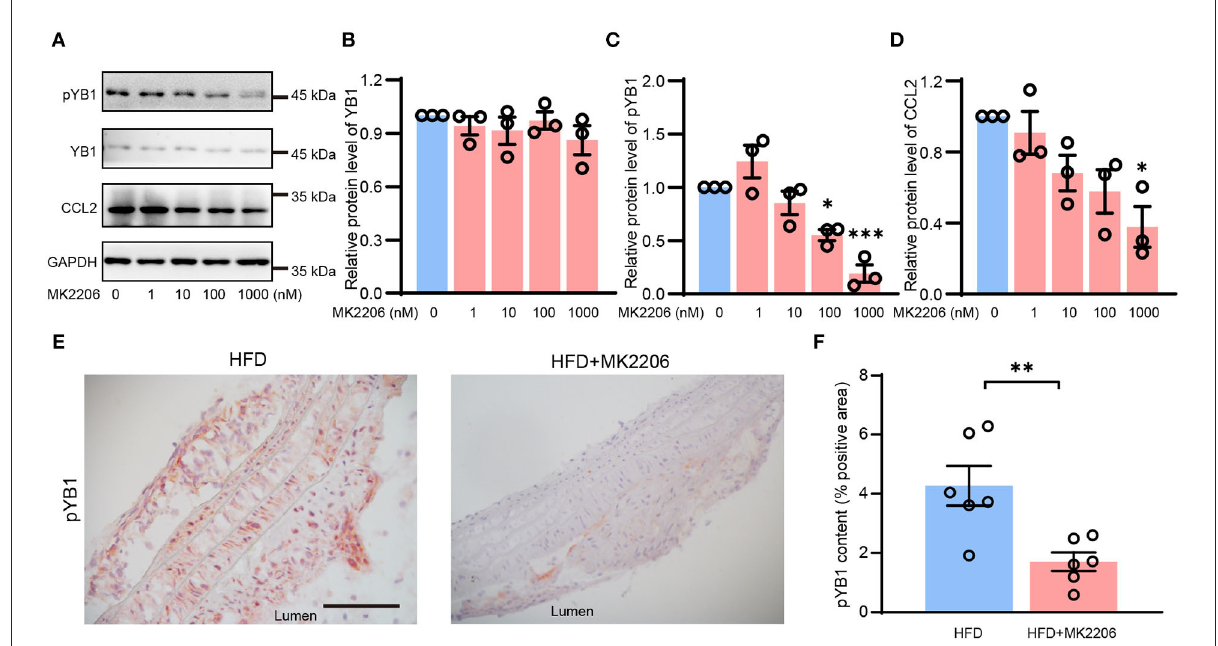
FIGURE6 MK2206 inhibited YB1 dephosphorylation and decreased CCL2 expression. Representative immunoblot images (A) and quantification of YB1 (B) , pYB1 (C) , and CCL2 (D) in VSMCs treated with MK2206 in a dose-dependent manner for 24h. (E) Representative images of immunohistochemical staining of CCL2 in the mouse aortic arch from HFD and HFD + MK2206 group, and the related quantitative analysis (F) . Data are presented as the mean ± SEM. Student’s two-tailed t -test. * P < 0.05, ** P < 0.01, *** P < 0.001 vs. 0nM group or HFD group. Scale bar = 50 µ m ( n = 3 to 6 for each